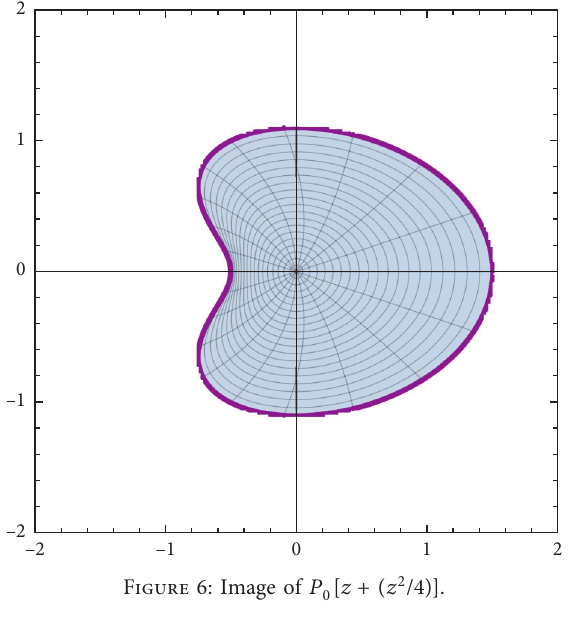
Figure 6: Image of P